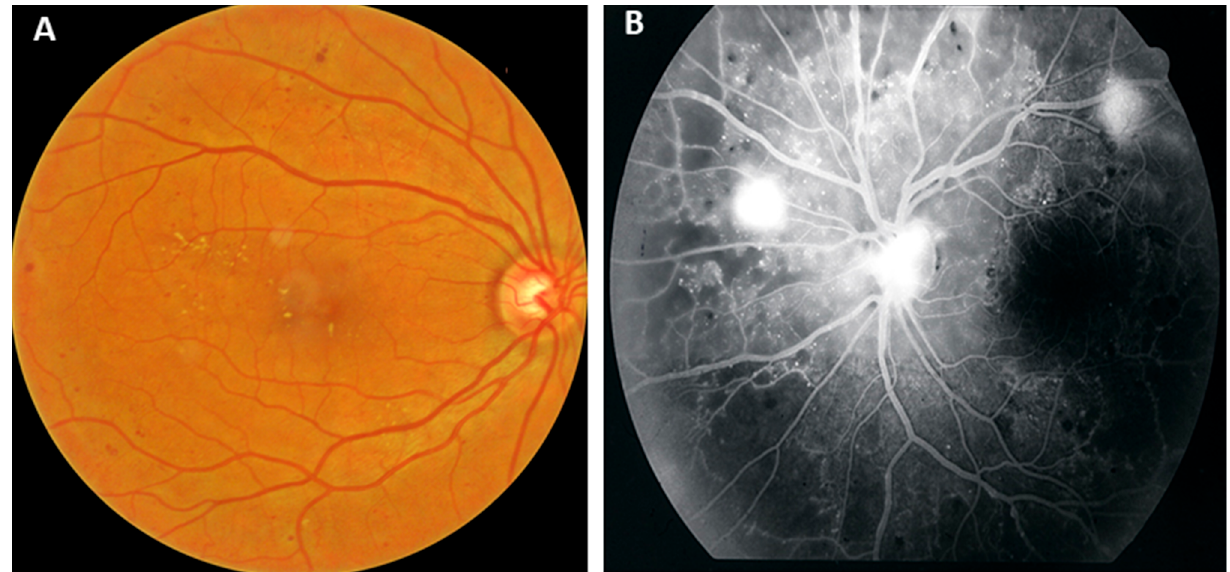
Figure 1. ( A ) Color fundus photograph of a patient with non-proliferative diabetic retinopathy (moderate-to-severe). ( B ) Fluorescein angiography of a patient with proliferative diabetic retinopathy, where neovascularization on the disc or elsewhere are depicted as hyperreflective leakage points. Note also non-perfusion areas as hypofluorescence especially in the periphery.